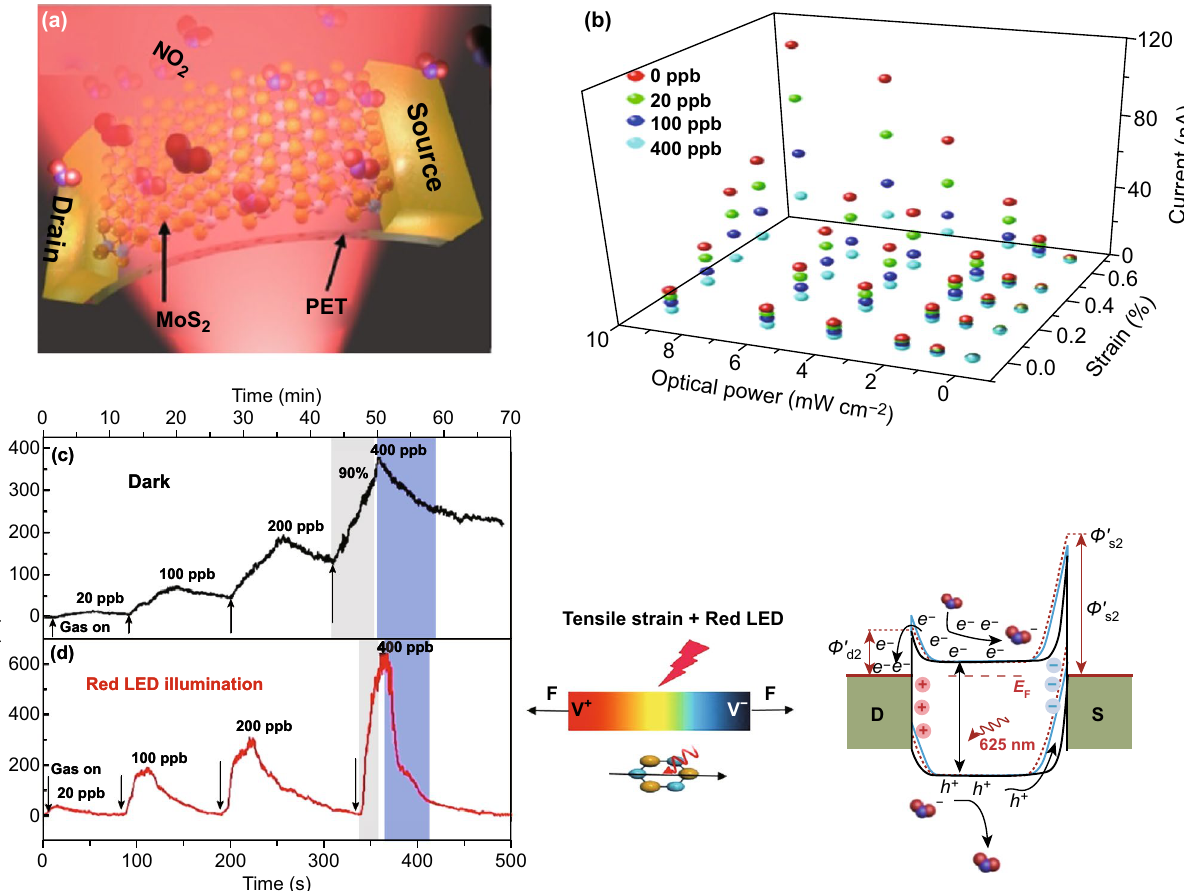
Fig. 15 a Schematic representation of a flexible MoS 2 sensor under red light illumination. b Device current in different concentrations of NO 2 gas ambient under different optical power of red light illumination with an applied different strain. Gas response to different concentrations of NO 2 gas of the flexible sensor under c dark and d red illumination. e Gas sensing mechanism of the flexible MoS 2 sensor via energy band dia- gram under tensile strain and red illumination. Reproduced with permission [129]. Copyright 2018, Science China Press. Published by